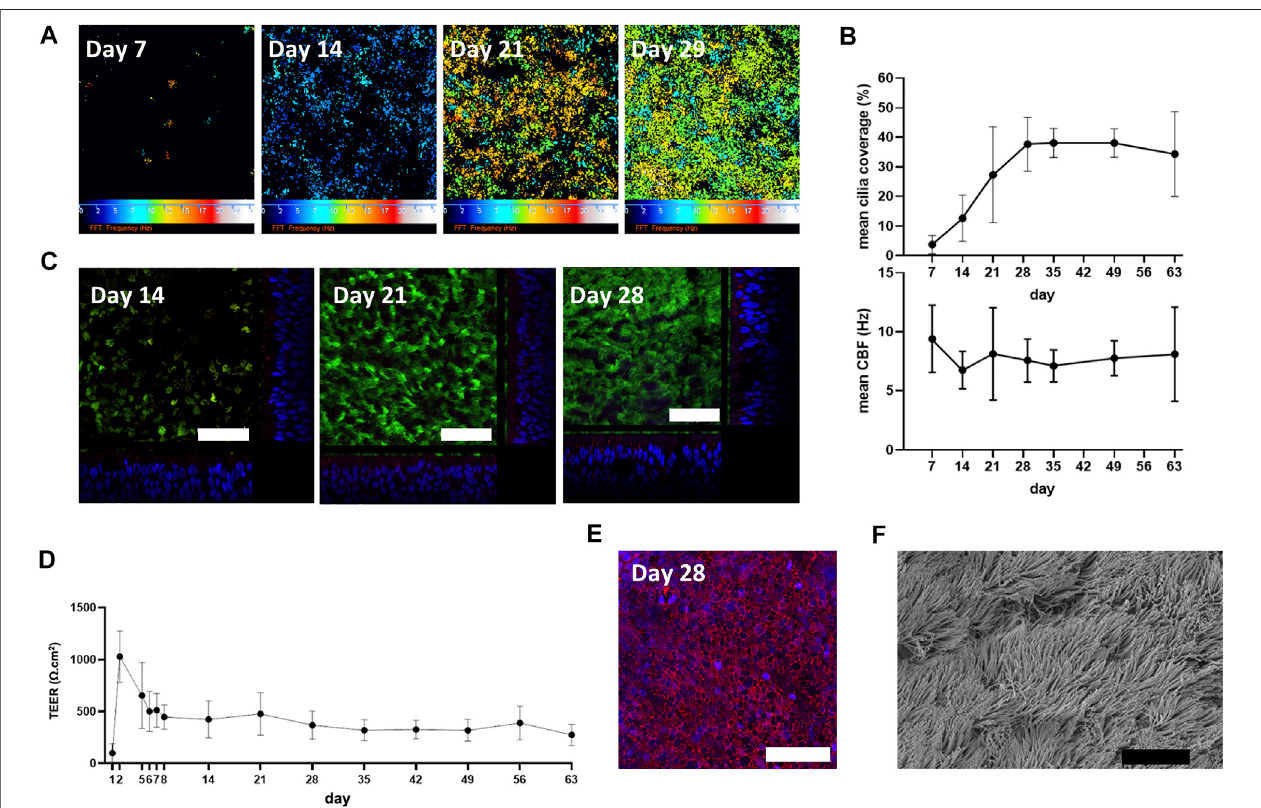
FIGURE1| Physiologicalcharacterization of invitro ALI-cultures. (A) “ Colourmap ” outputsofciliarymovementdetectedby insitu high-speedvideomicroscopyat 37 ° C. Colour scale represents increasing ciliary beat frequency (CBF) from 0 (black) to 25 Hz (white), where black also represents CBF measurements outside of the detection threshold (below 2 Hz or above 50 Hz). (B) Cilia were detected at day 7 with a weekly increase in percentage cilia coverage up to day 29 (plateau). Mean CBF ( n = 3) was measured in situ at 37 ° C. (C) Immuno fl uorescence staining of a-tubulin (cilia; Alexa fl uor488 secondary antibody, green), MUC5AC (goblet cells; Alexa fl uor594 secondary antibody, red) and DAPI (blue) (representative images from n = 3). Orthogonal views show cellular position of α -tubulin and increasing cytoplasmicMUC5ACexpressionandepitheliumheightfromday7today28. (D) Membranebarrierfunctionwasassessedbytransepithelialelectricalresistance(TEER) measurements with stability observed from day 28. Mean ± SD from n = 3. (E) Maximum projection shows total E-cadherin (cell-cell adhesion molecule; Alexa fl uor488 secondary antibody, red) and DAPI (blue) expression at day 28 (representative image from n = 3). (F) Scanning electron microscopy (representative of n = 2) supports widespread ciliation at day 28. White scale bar = 50 µm. Black scale bar = 10 µm.